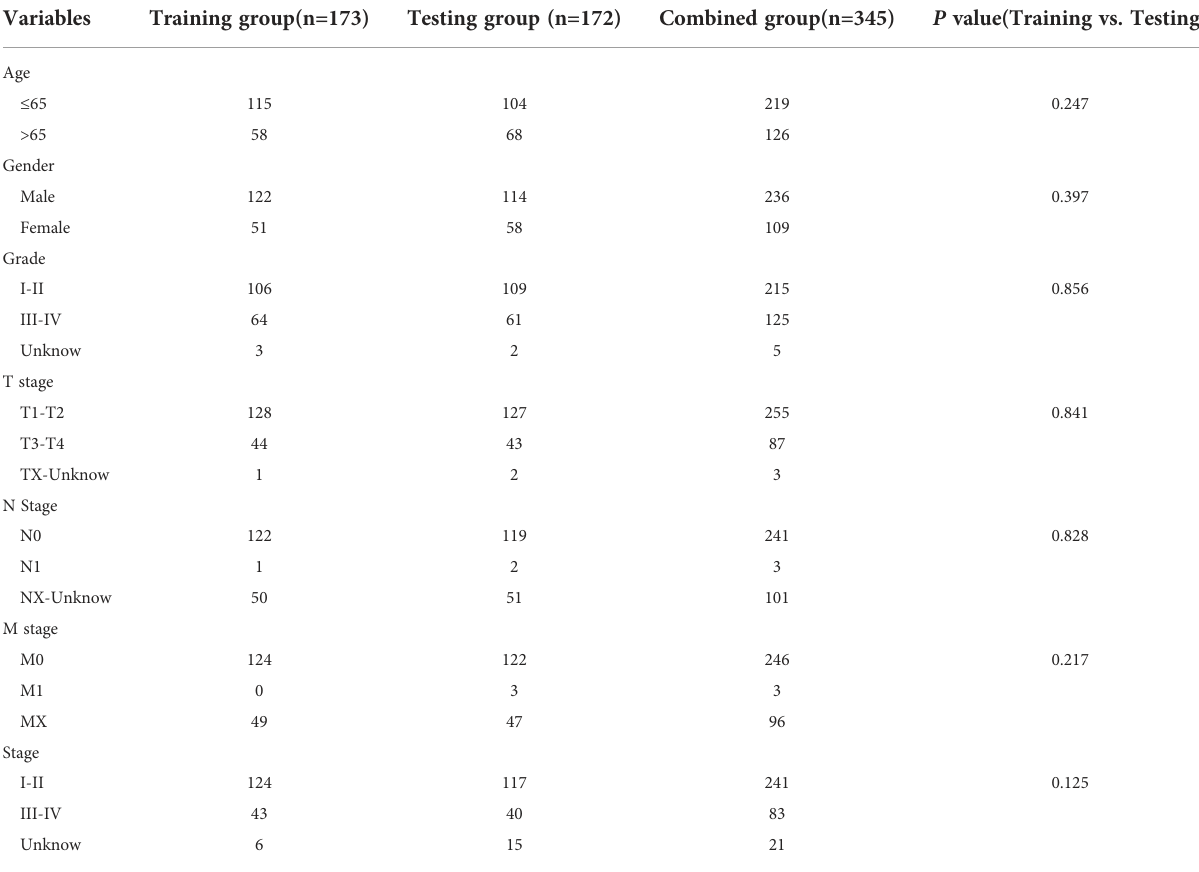
TABLE 1 The clinical characteristics of patients in different